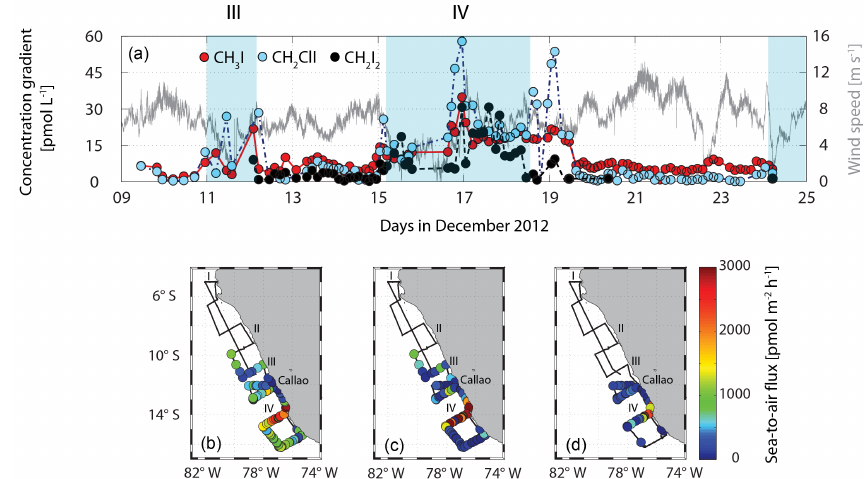
Figure 6. The concentration gradient of CH 3 I, CH 2 ClI and CH 2 I 2 along with wind speed (grey) is shown in panel (a) , while the sea-to-air flux is depicted in panel (b) for CH 3 I, (c) for CH 2 ClI and (d) for CH 2 I 2 . Note the colour bar on the right.